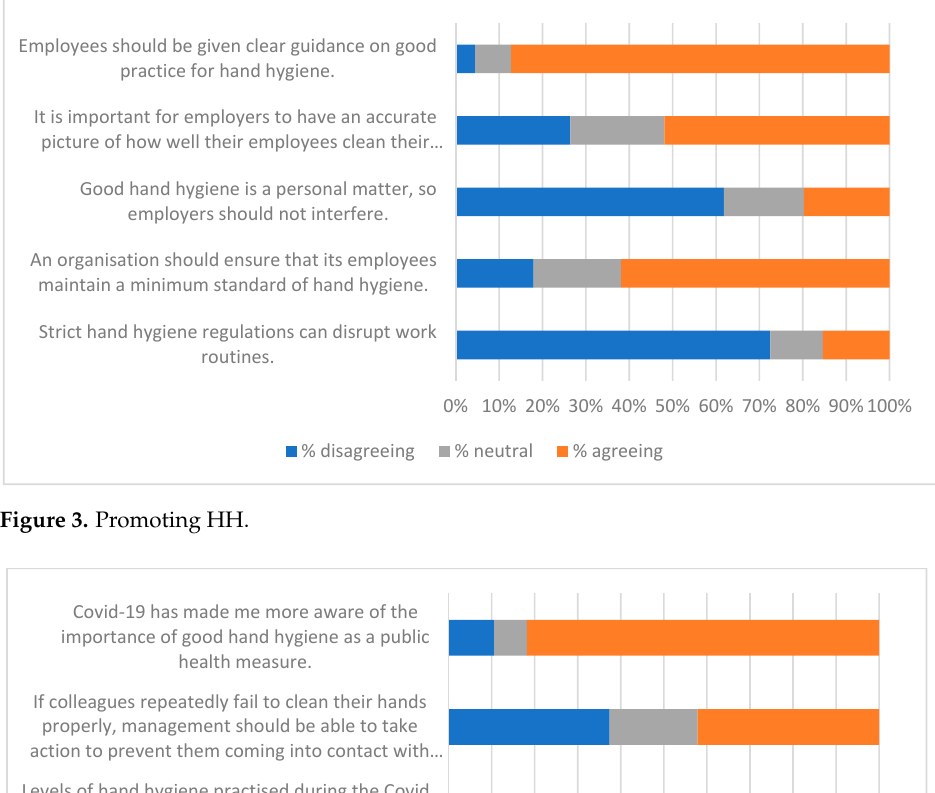
Figure 2. Investing in HH.